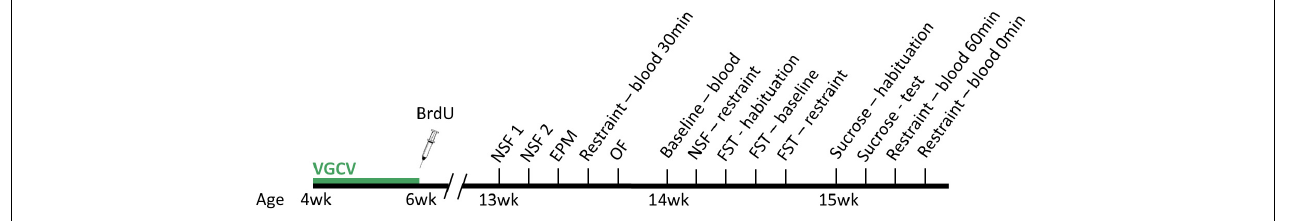
FIGURE 1 | Experimental design. Wildtype and transgenic rats were given valganciclovir (VGCV) and concurrent bromodeoxyuridine (BrdU) injections during the first two weeks of adolescence, and were afterward undisturbed. Starting at 13 weeks old, all rats were tested on anxiodepressive tests at baseline and following acute restraint, including novelty-suppressed feeding (NSF), elevated plus-maze (EPM), open field (OF), sucrose preference, and forced swim (FST). Blood was collected at various times following the cessation of acute restraint stress to measure corticosterone levels as well. Rats were euthanized at 16 weeks old for